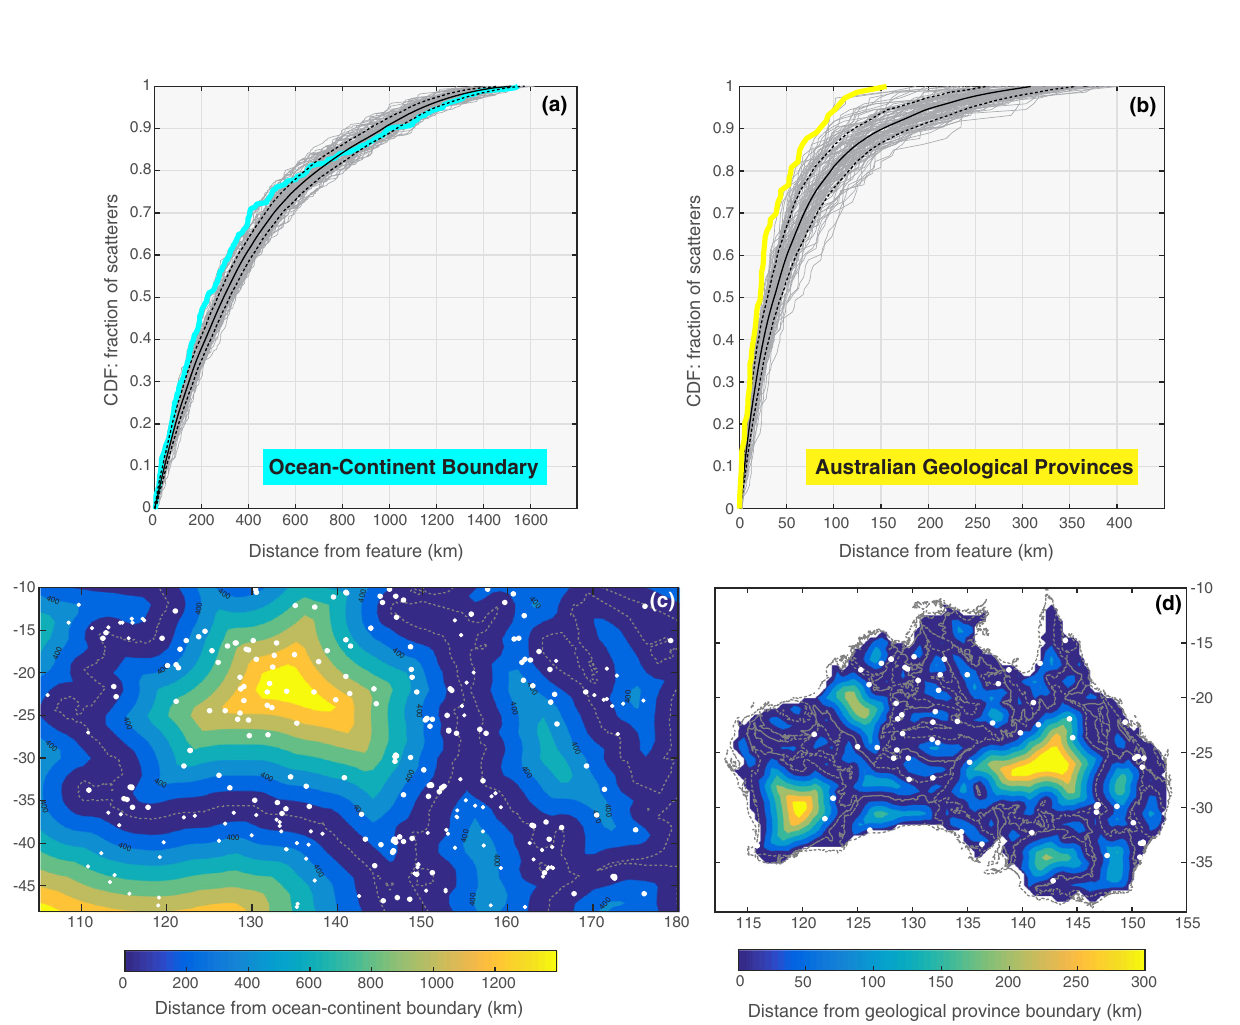
Fig. 4 Distance of QL scatterers relative to associated features. a , b Cumulative distribution functions (CDF) showing the fraction of all observed QL scatters as a function of distance from the ocean-continent boundary 29 (cyan line) and major geological provinces (yellow line) 34 . The same CDFs are generated for 100 sets of the equivalent number of points randomly located across the study area (thin grey lines), alongside their mean (solid black line) and one standard deviation (dotted black line). c , d Maps showing spatial distribution of QL scatterers (small white symbols) compared to contours of the distance from either the ocean-continent boundary ( c ) or the geological province boundaries ( d ).